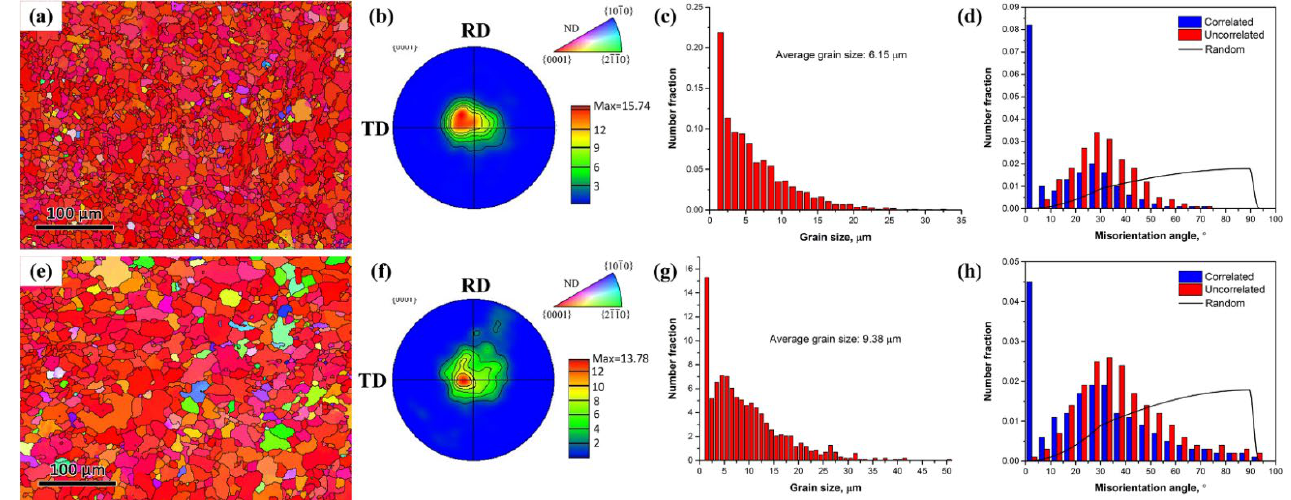
Figure 3. EBSD images, (0002) pole figure, IPF map, distribution histogram of grain size and misorientation distribution of the CI and CA samples: ( a – d ) the CI sample; ( e – h ) the CA